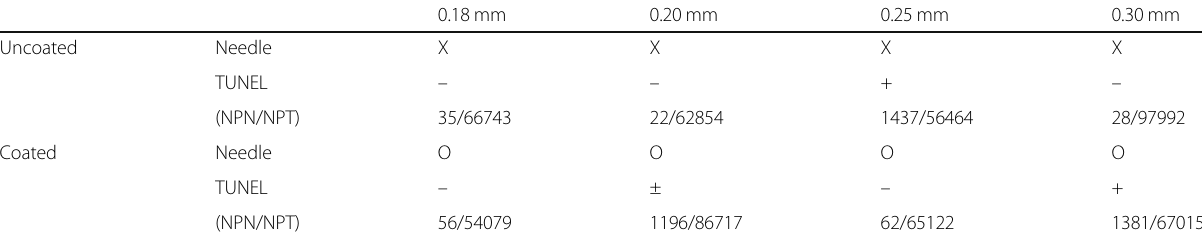
Table 3 Corrosion of STS316 after EA application in tissue and TUNEL assay results (NPN: Number of pixels with tissue necrosis, NPT: Number of pixels with total